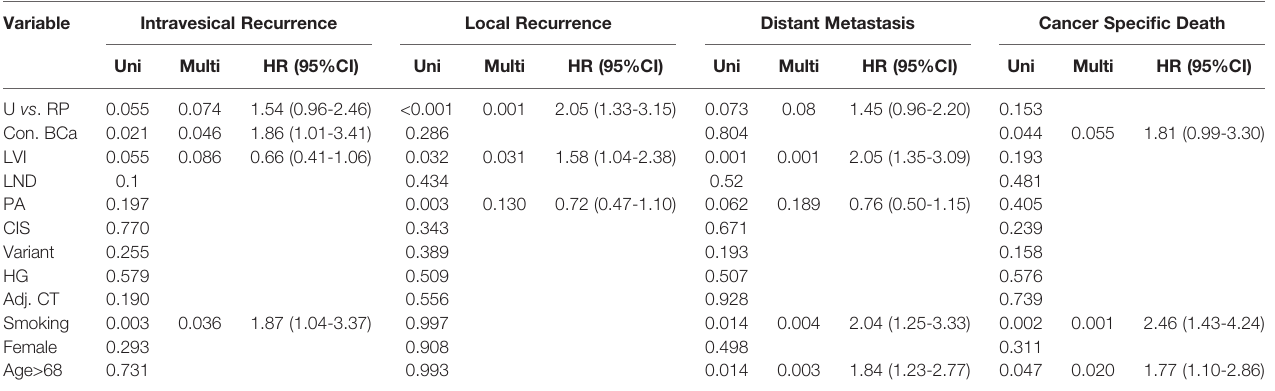
TABLE 2 | Multivariate Cox proportional hazard regression analyses to predict oncological outcome from upper tract urothelial carcinoma after radical nephroureterectomy.